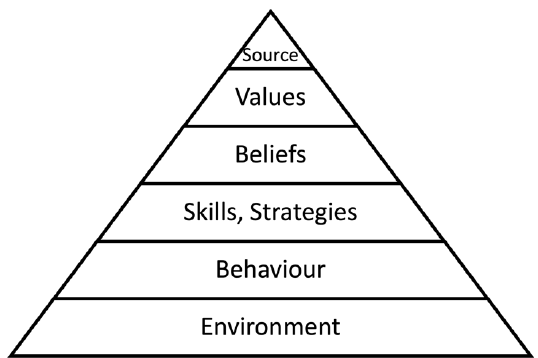
Figure 3. Logical categories of learning [41].